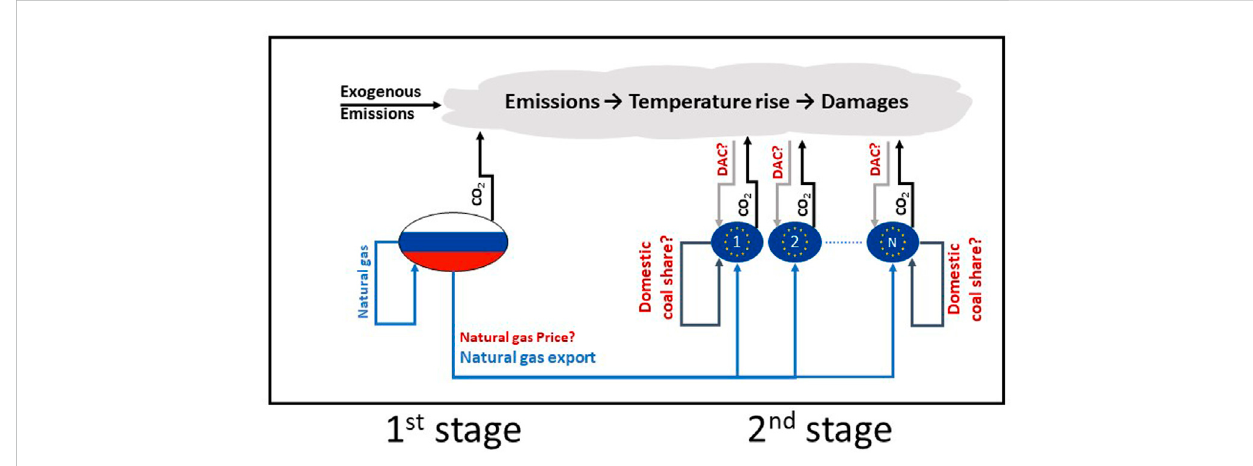
FIGURE 1 Energy security and climate stability dynamics. In the fi rst stage, Russia decides about the price of exported natural gas. In the second stage, the EU countries decide about the share of domestic coal to secure their energy demand, and the level of direct air capture (DAC) to stabilize the